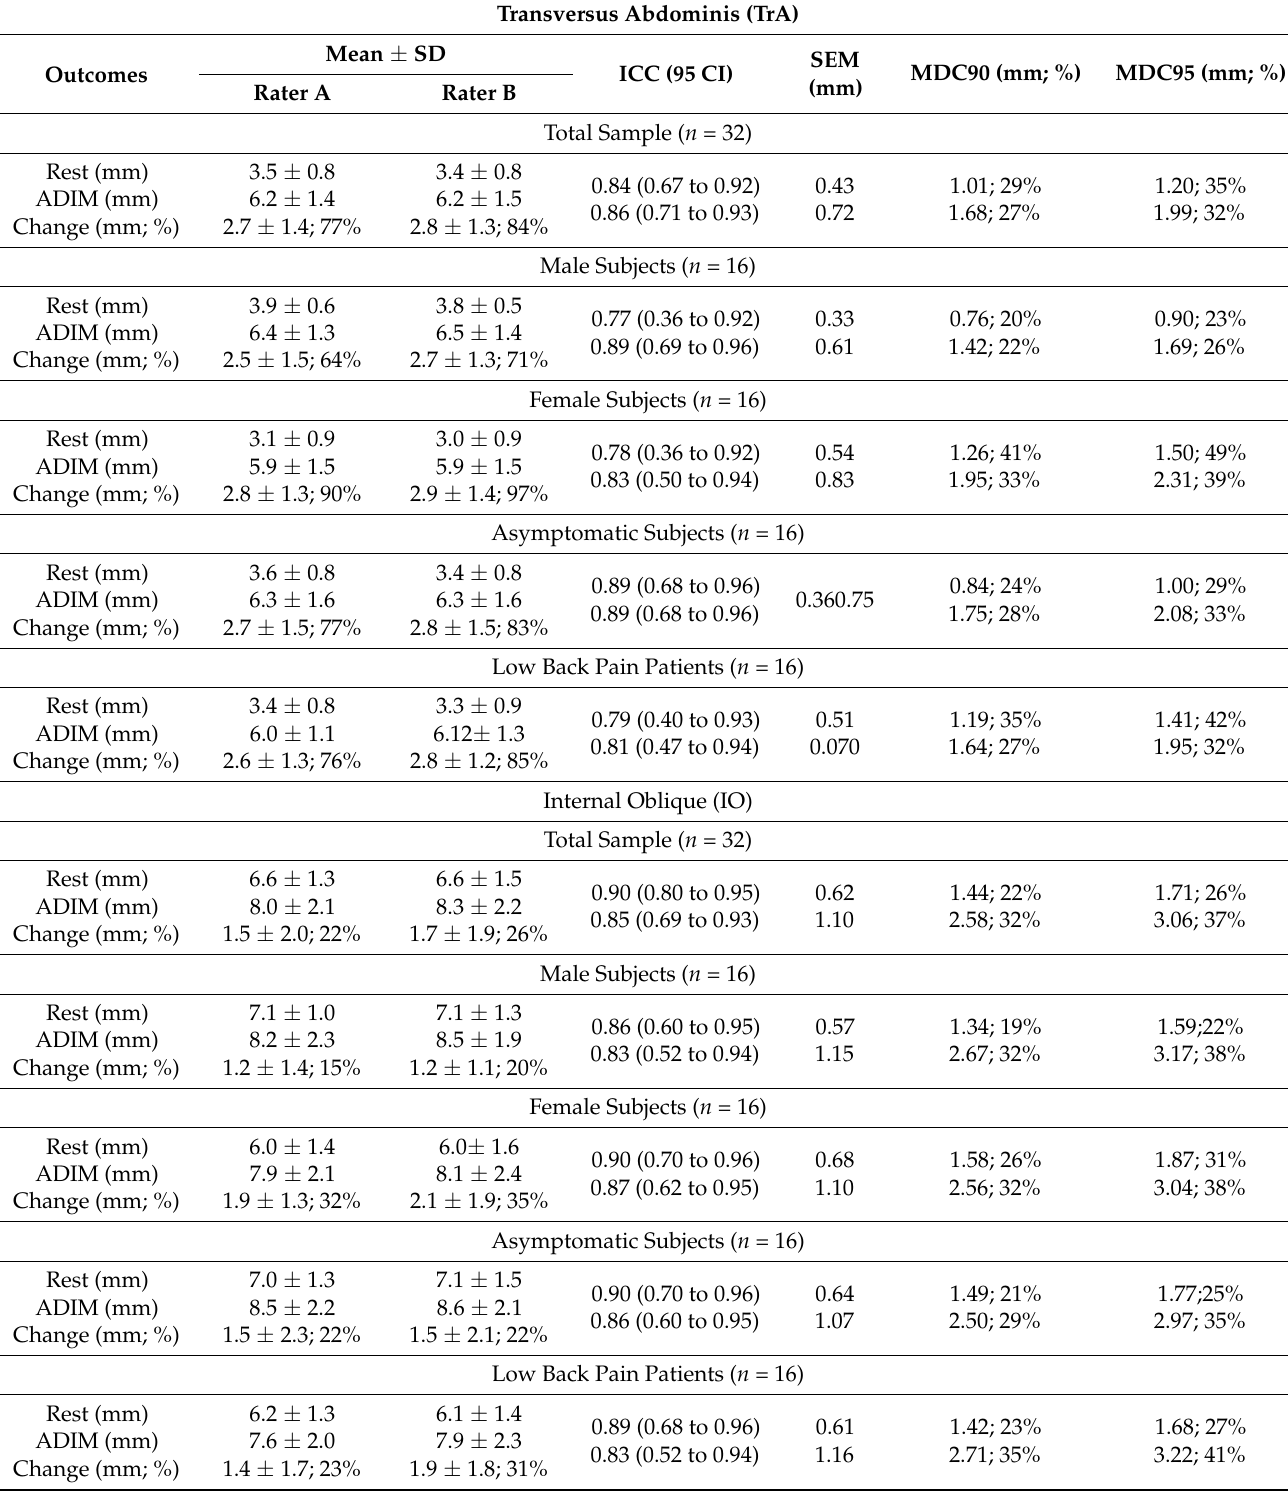
Table 2. Interrater reliability of ultrasound muscle thickness at rest and during the ADIM. Transversus Abdominis